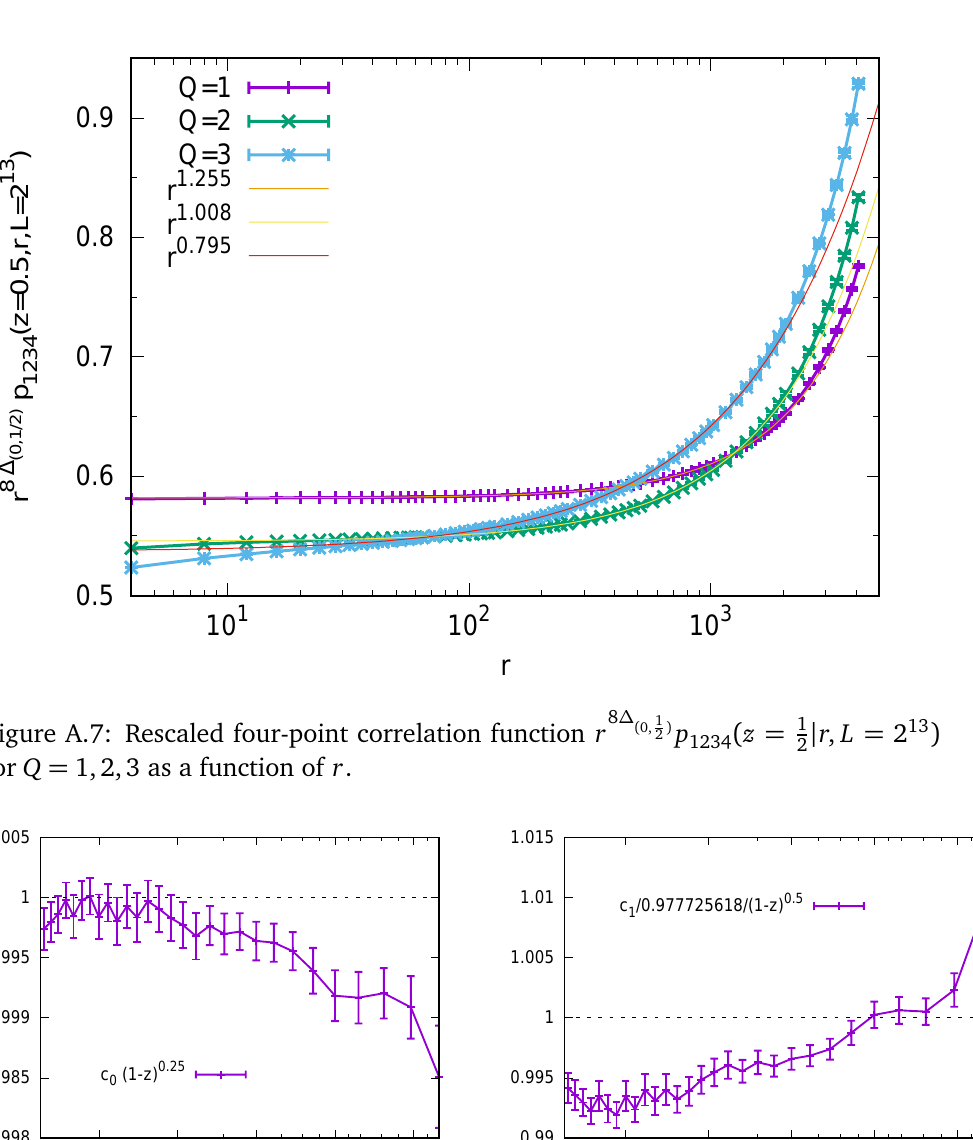
Figure A.8: Q = 2 comparison between Monte-Carlo measurements and exact results for leading (left) and subleading (right) contributions to four-point